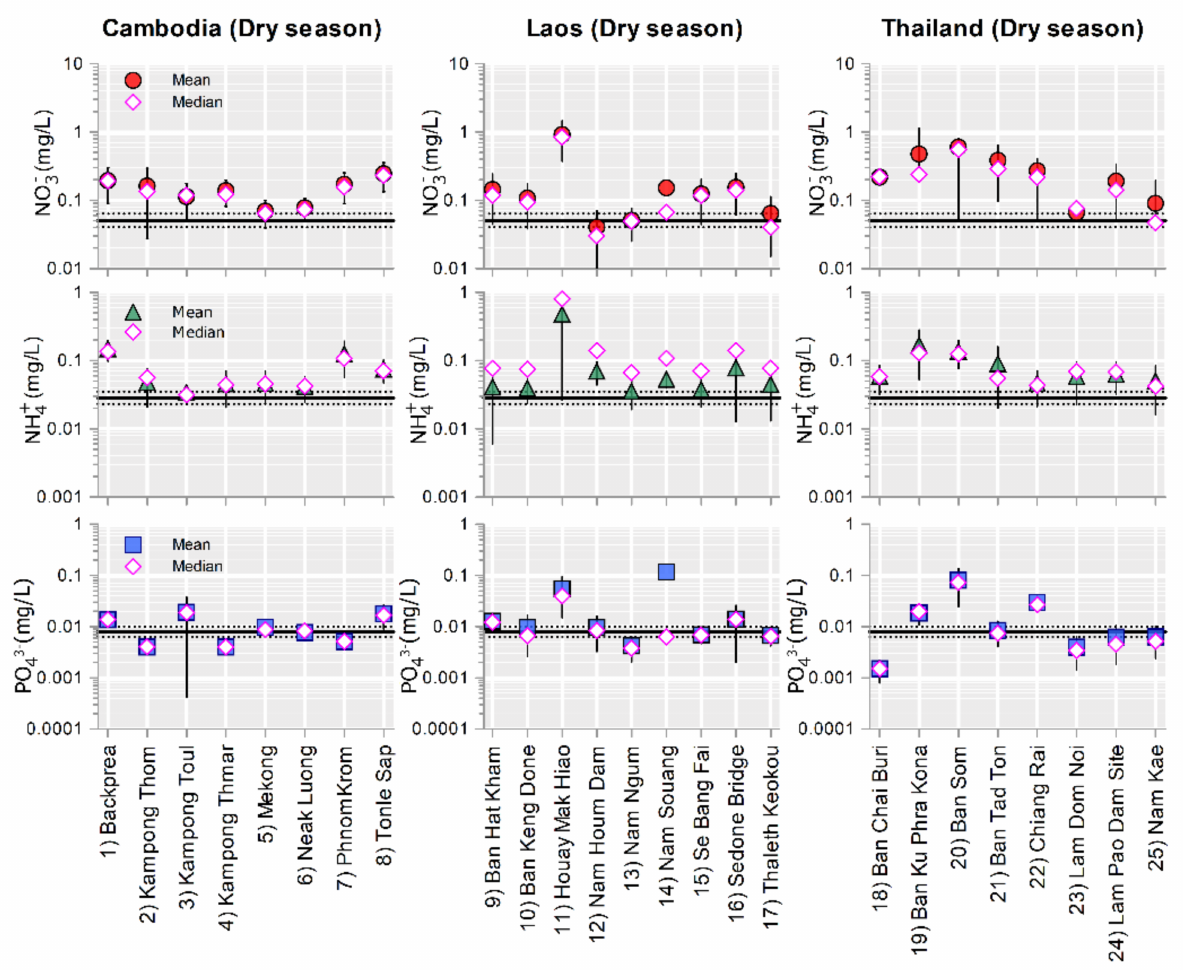
Figure 5. Mean NO 3 − , NH 4+ , PO 43 − concentrations for the dry season in Cambodia, Laos, and Thailand. Black horizontal lines report reference values and dotted lines correspond to the 95% confidence